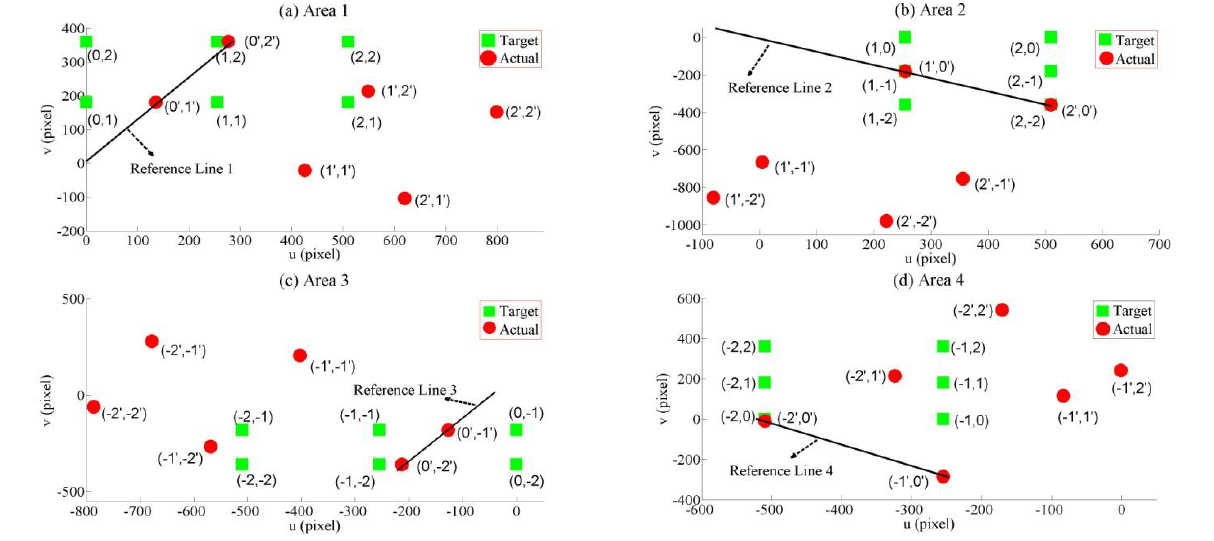
Figure 7. Actual and target pixels from the